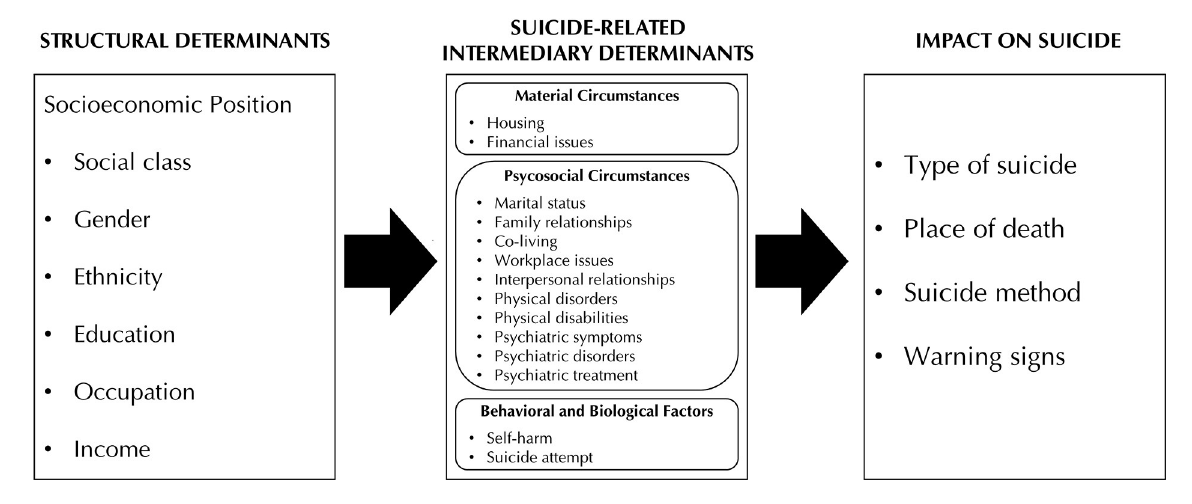
FIGURE1 Conceptual framework for understanding social determinants of